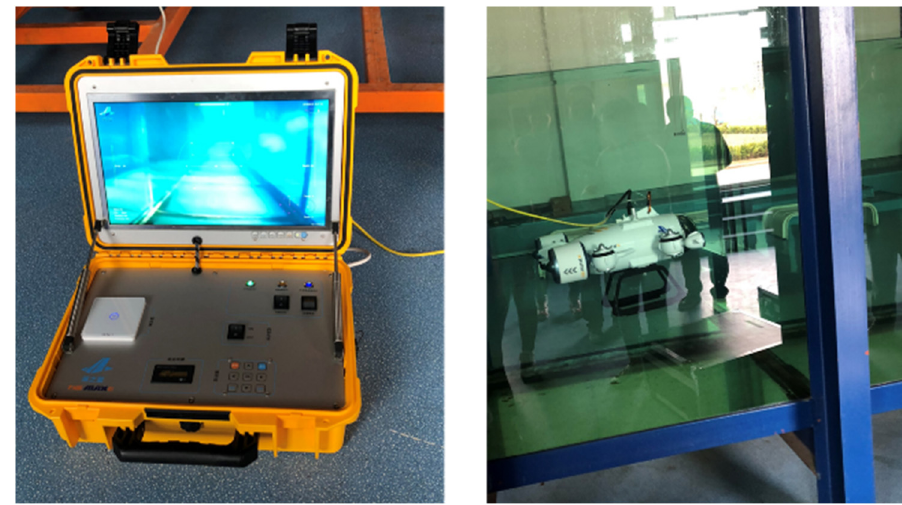
Figure 3. Tail flow experimental vessel.